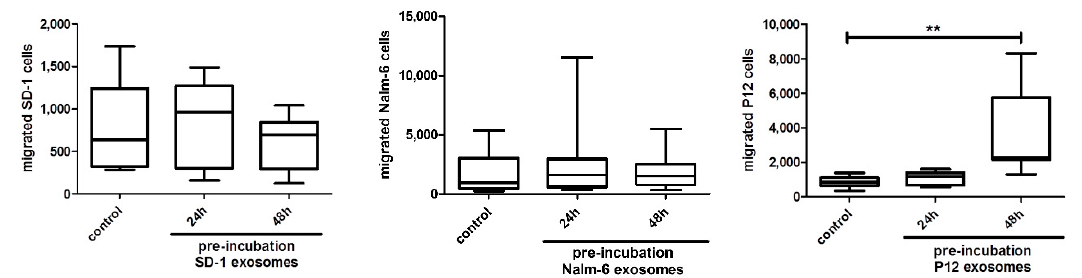
Figure 3. Exosomal pre-incubation enhances transmigration across blood-cerebrospinal fluid barrier (BCSFB) in vitro model of T-ALL cell line P12 but not of B-cell precursor (BCP)-ALL cell lines in time-dependent manner. CellTracker ™ Green labeled ALL cells were added for 6 h onto the basolateral side of untreated HiBCPP cells or HiBCPP cells pre-incubated with 16 µ g unlabeled exosomes for indicated time-points. C-X-C motif chemokine ligand 12 (CXCL12) (100 ng / mL) was used as chemoattractant. Migrated ALL cells (SD-1, Nalm-6, and P12, respectively) were quantified in the lower compartment by fluorescent microscopy (10 fields of view, 10 × objective). Data shown are box plots with whiskers of at least 3 independent experiments performed in triplicates. * p < 0.05; ** p < 0.01; *** p < 0.001.